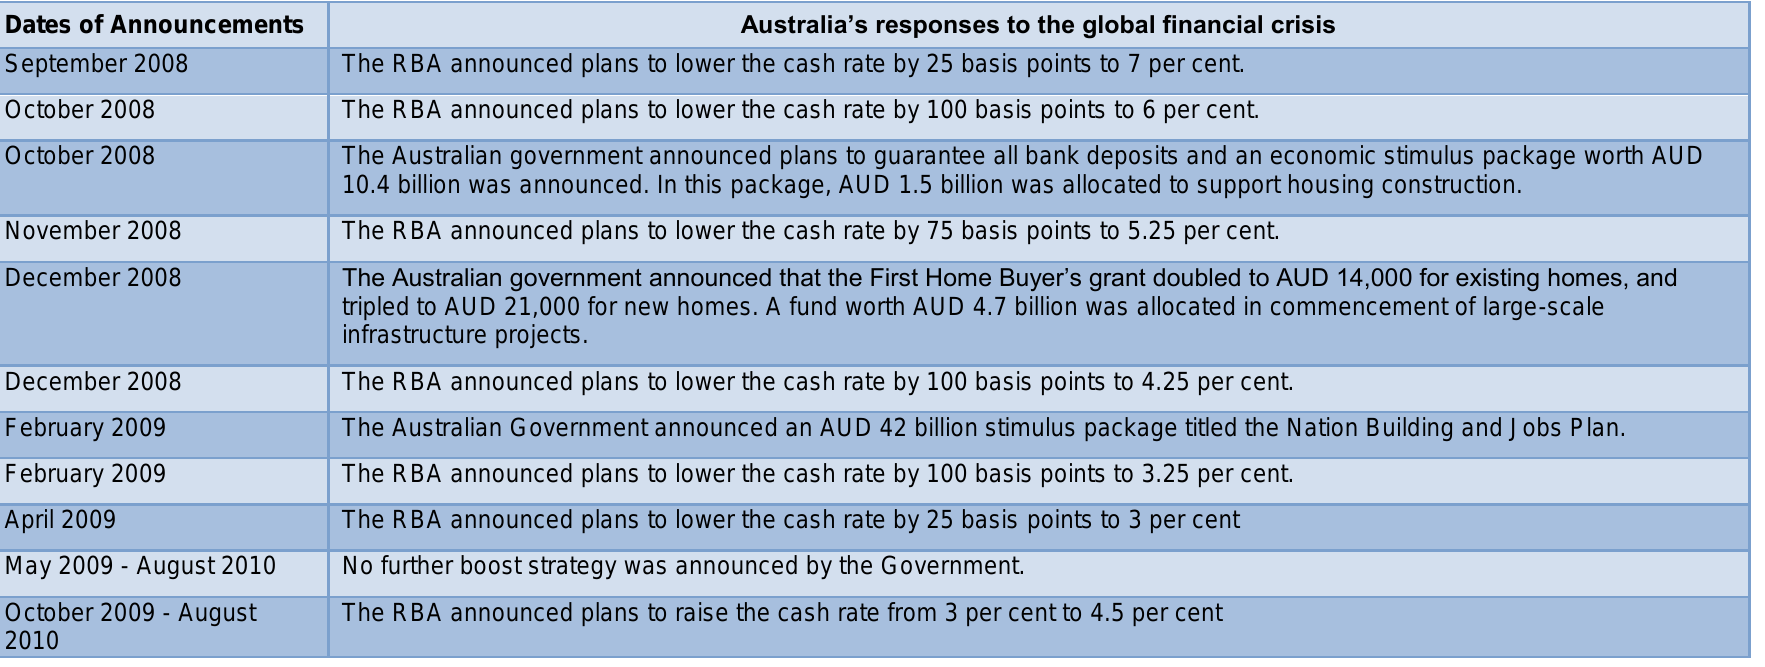
Table 5 Australia’s response to the late 2 000s global financial